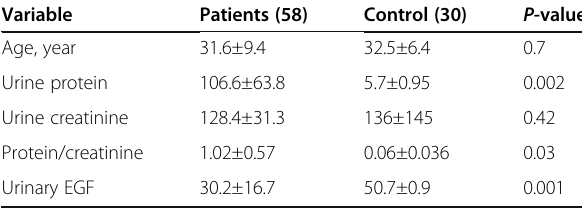
Table 2 Comparison between the patients and the controls Variable